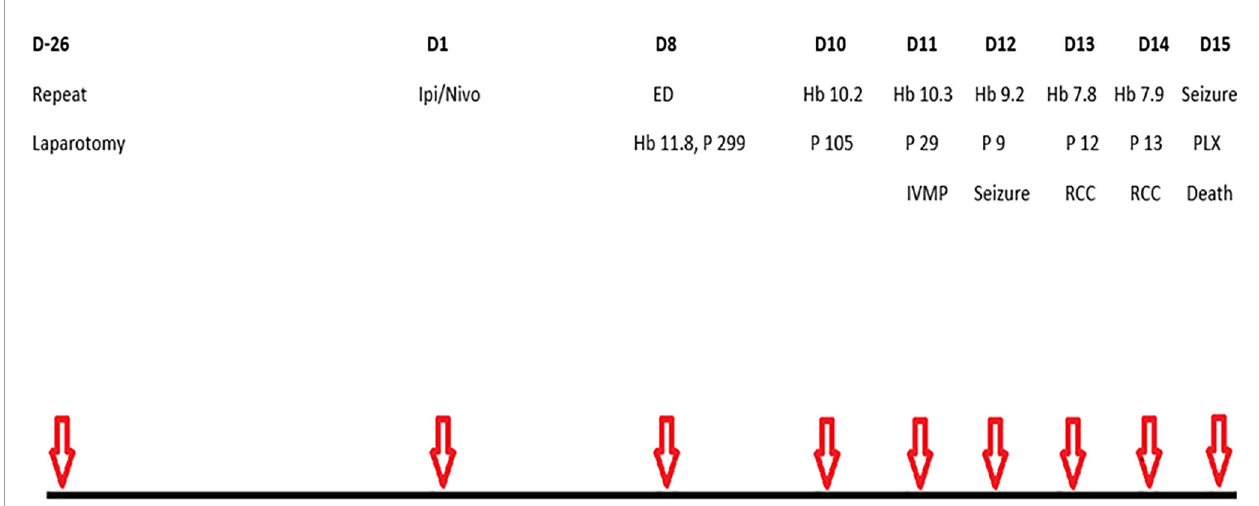
FIGURE 2 | Schematic of main events. D, day; Ipi, ipilimumab; Nivo, nivolumab; ED, emergency department presentation with abdominal pain and fatigue; Hb, haemoglobin (g/dl); P, platelets (X10 9 /l); IVMP, intravenous methylprednisolone; RCC, red cell concentrate, PLX,